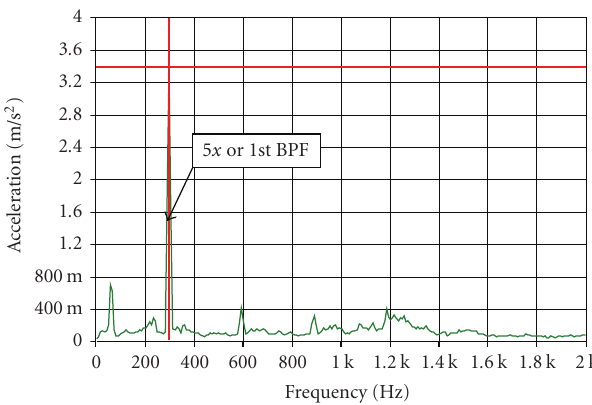
Figure 10: Typical vibration signal of model pump casing at Q/Q n = 0 . 5.